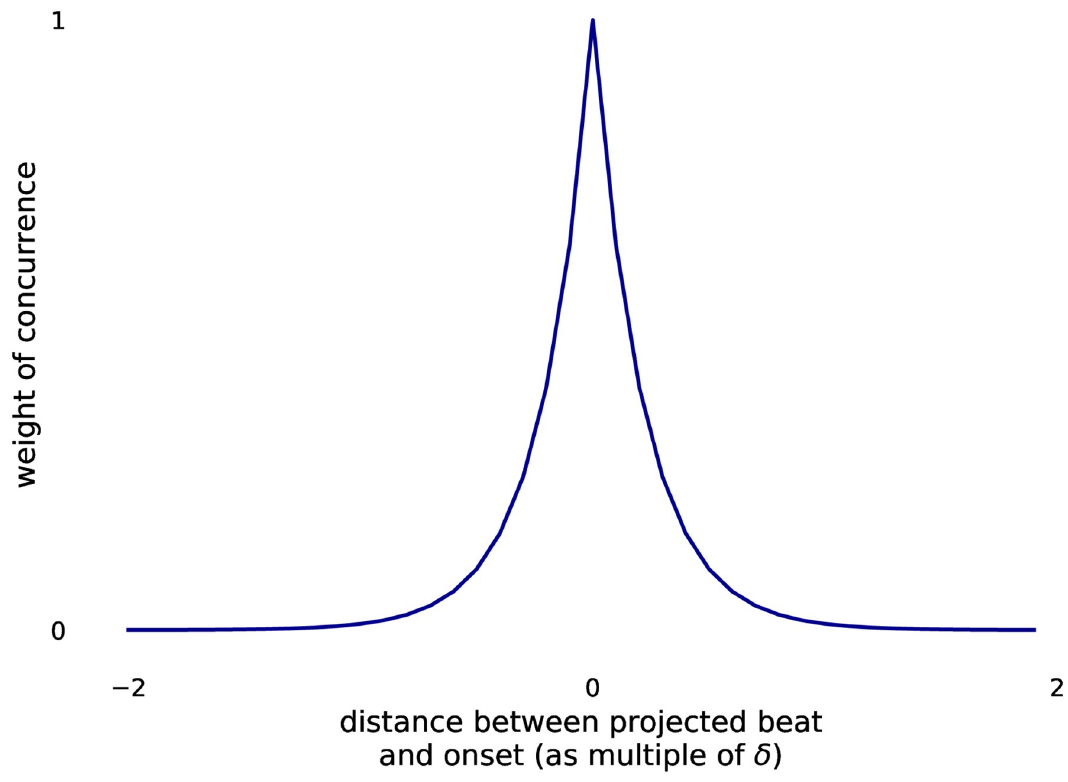
Fig 2. Shape of the concurrence weight function.